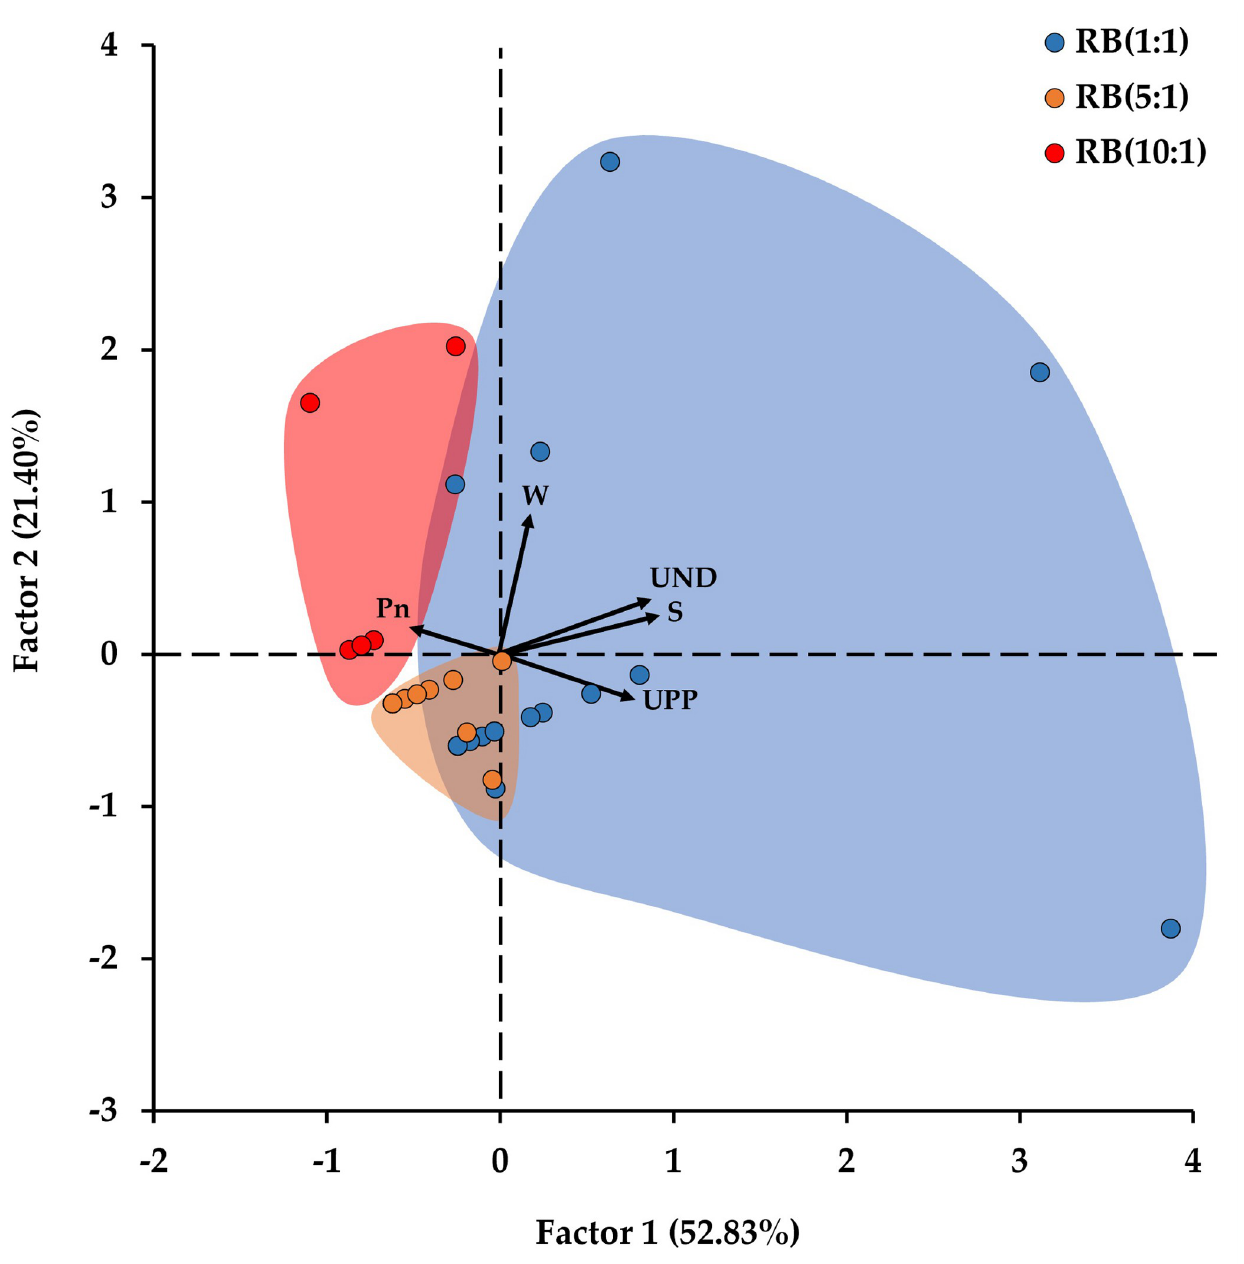
Fig 5. The factor score distribution of factor analysis, showing the relation between aphid and host plant, using net photosynthetic rate (Pn; μ molm -2 s -1 ) of Eutrema japonicum , the number of alate (W) and apterous (S) aphids, and the number of aphids on the upper side (UPP) and lower side (UND) of Eutrema japonicum leaves. The arrows indicate the factor loadings on each variable. RB represents the ratio of red and blue mixed light.